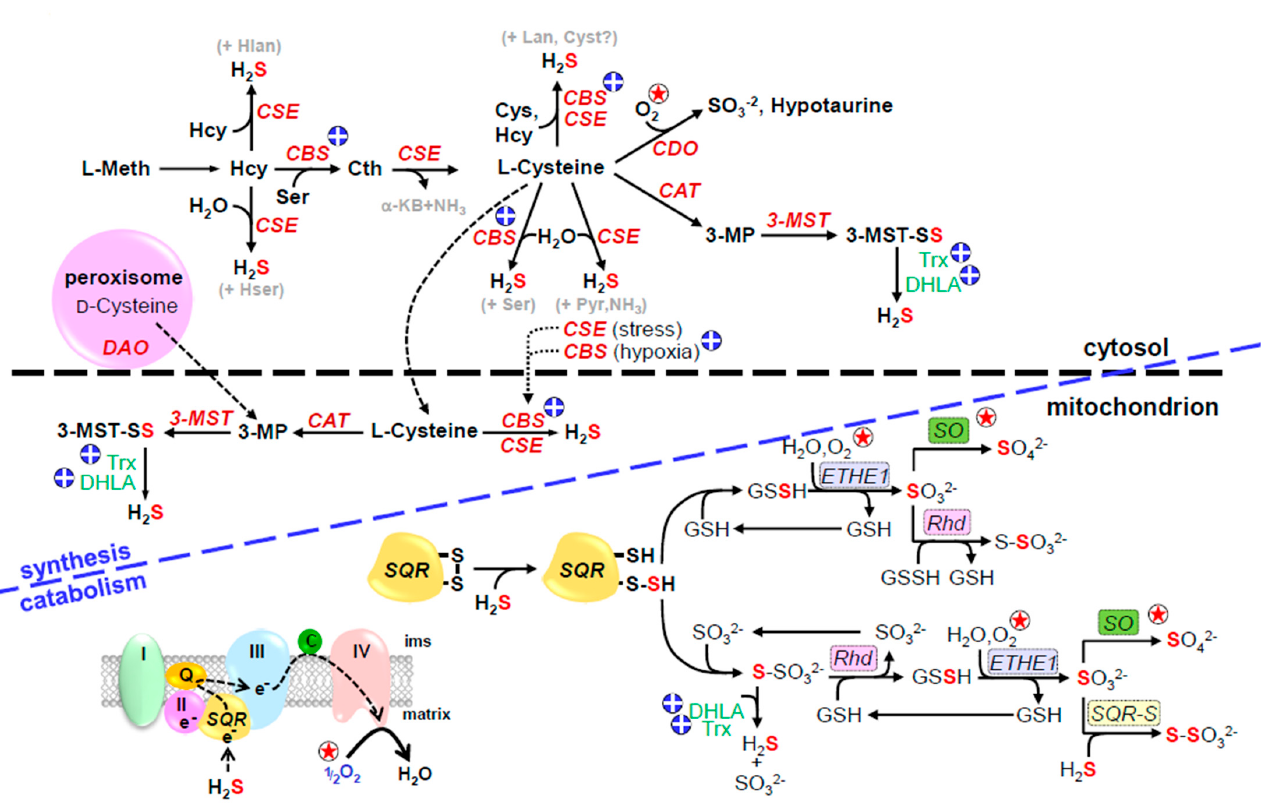
Figure 1. Canonical pathways for H 2 S production and degradation; circled star indicates O 2 -sensitive reactions, circled plus indicates reactions affected by hypoxia-induced increased reducing environment. Cytosolic enzymes, cystathionine β -synthase (CBS) and cystathionine γ -lyase generate H 2 S from homocysteine (Hcy) or cysteine. In addition, cysteine aminotransferase (CAT, also known as aspartate aminotransferase, AST, or glutamate transaminase, GOT) transfers sulfur from cysteine to α -ketoglutarate to form 3-mercaptopyruvate (3-MP) and the sulfur is then transferred to 3-mercaptopyruvate sulfur transferase (3-MST) to form a 3-MST persulfide (3-MST-SS). Both CAT and 3-MST are found in the cytosol and mitochondrion. H 2 S can be liberated from 3-MST-SS by intracellular reductants, dihydrolipoic acid (DHLA), or reduced thioredoxin (Trx). 3-mercaptopyruvate can also be produced from D -cysteine in the peroxisome by D -amino acid oxidase (DAO) which is shuttled to the mitochondrion. During hypoxia CBS migrates from the cytosol to the mitochondrial matrix and in the absence of Lon protease degradation this will generate H 2 S from abundant cysteine in the matrix. CBS activity is also increased as the cell becomes more reduced. General reaction of H 2 S oxidation in the mitochondrion is shown in lower left of figure, blue letters to right show specific reactions. H 2 S is initially oxidized by sulfide:quinone oxidoreductase